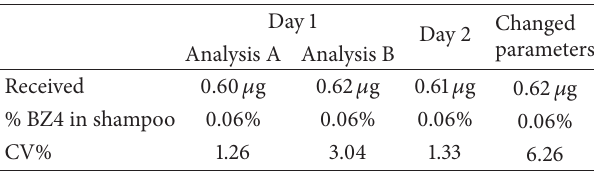
Figure 8: Linearity analysis for spectrophotometric calibration plots: analytical signal-to-analyte concentration versus concentra- tion, according to [18]. All absorbances were measured in triplicate.